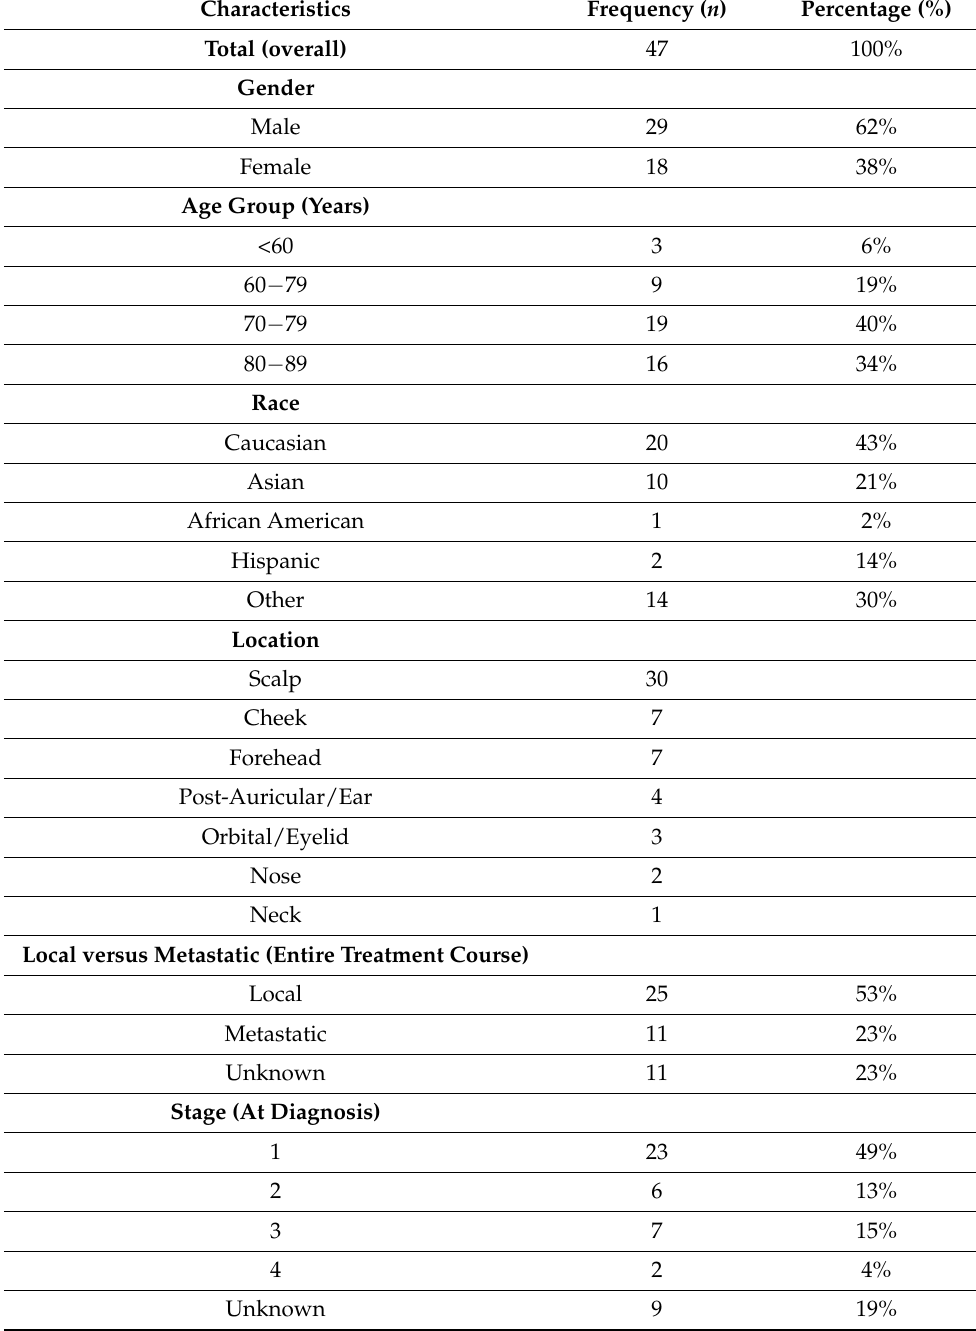
Table 1. Summary of patient